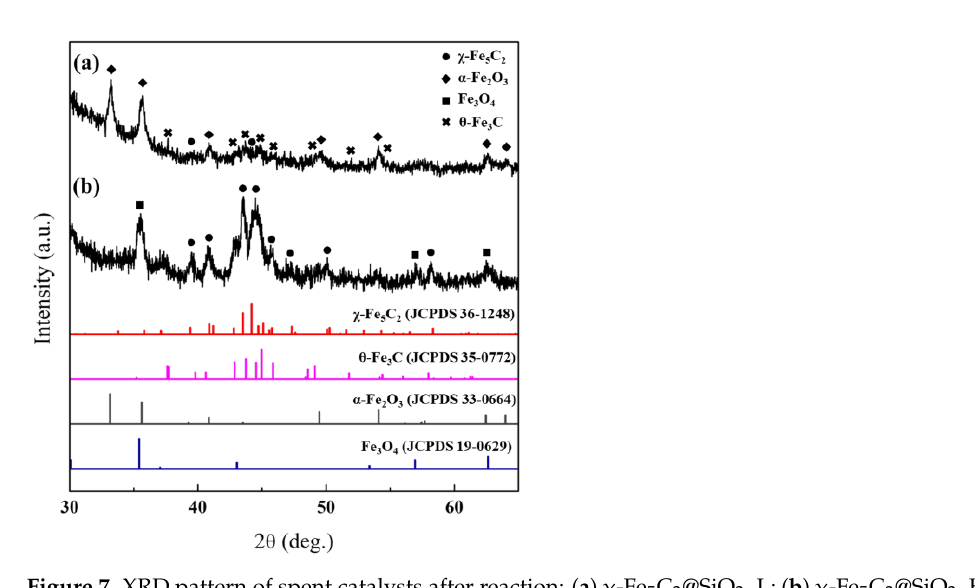
Figure 7. XRD pattern of spent catalysts after reaction: ( a ) χ -Fe 5 C 2 @SiO 2 _L; ( b ) χ -Fe 5 C 2 @SiO 2 _H.